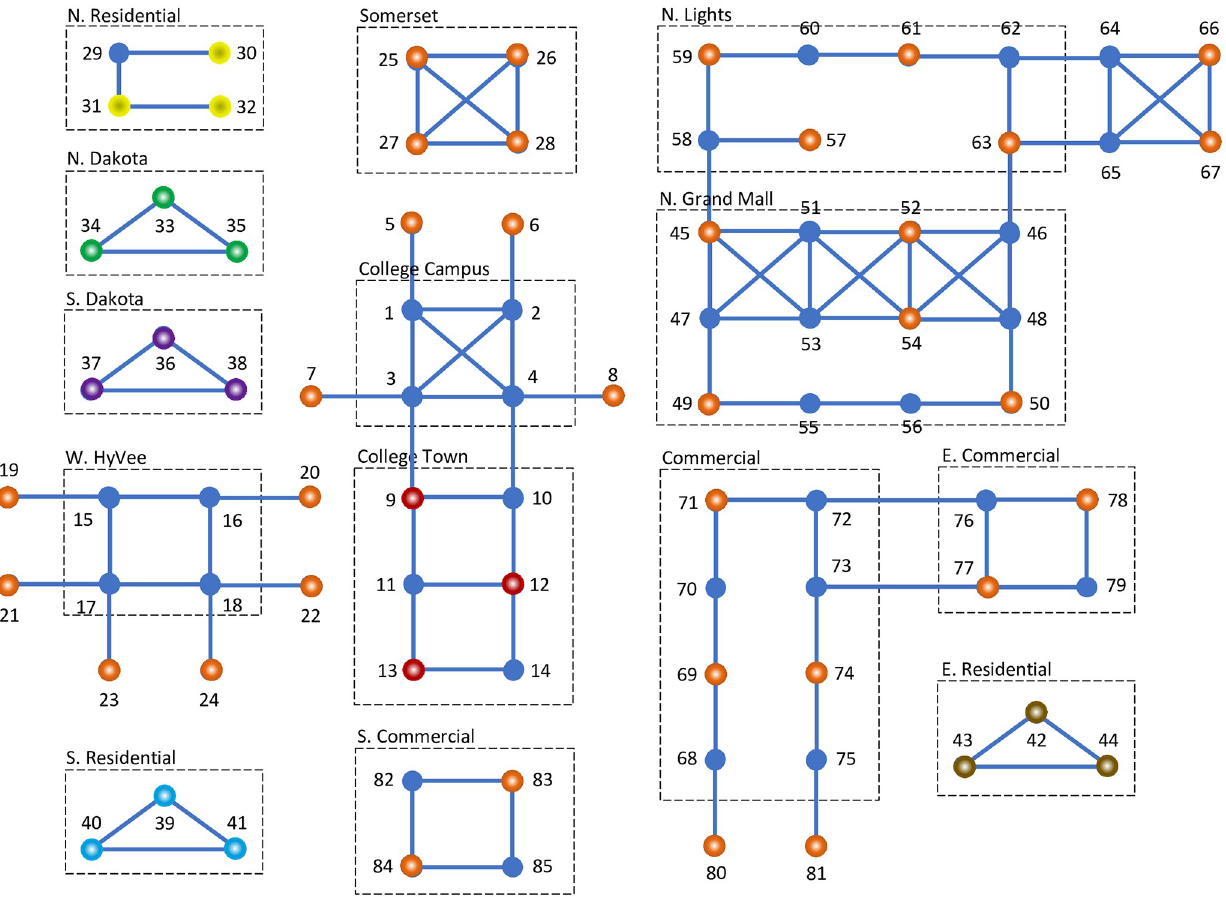
Fig 5. Simulation of social distancing in a university town. Nodes represent social activities. Links represent contact connections. The population is divided into 6 subpopulations, P 1 , ... , P 6 , each having a preferred subset of social activities. In the end of the simulation, a maximal independent set of regular groups of activities is selected by the subpopulations together. Those colored in dark blue are not selected by any subpopulation. Those colored in red are selected by P 1 , yellow by P 2 , green by P 3 , purple by P 4 , light blue by P 5 , brown by P 6 , and orange by more than one